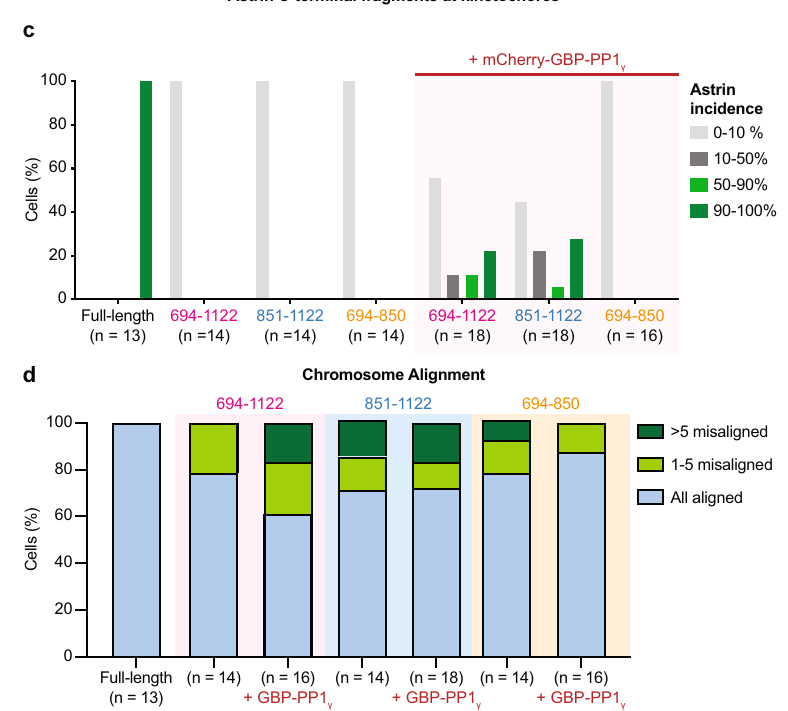
whether the arrival of Astrin-SKAP and departure of Cyclin-B- CDK1 at kinetochores are correlated. Immunostaining studies of RPE1 cells using antibodies against SKAP and Cyclin-B revealed prometaphase kinetochores displaying either SKAP or Cyclin-B signals (Fig. 6a, b), suggesting a departure of Cyclin-B in Astrin-SKAP enriched kinetochores. This was con fi rmed by